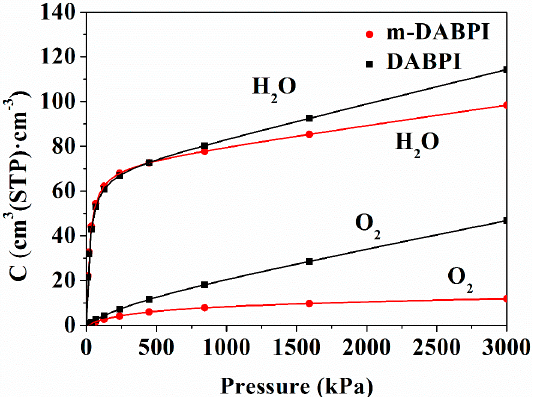
Figure 12. Adsorption isotherms of O 2 and H 2 O in DABPI and